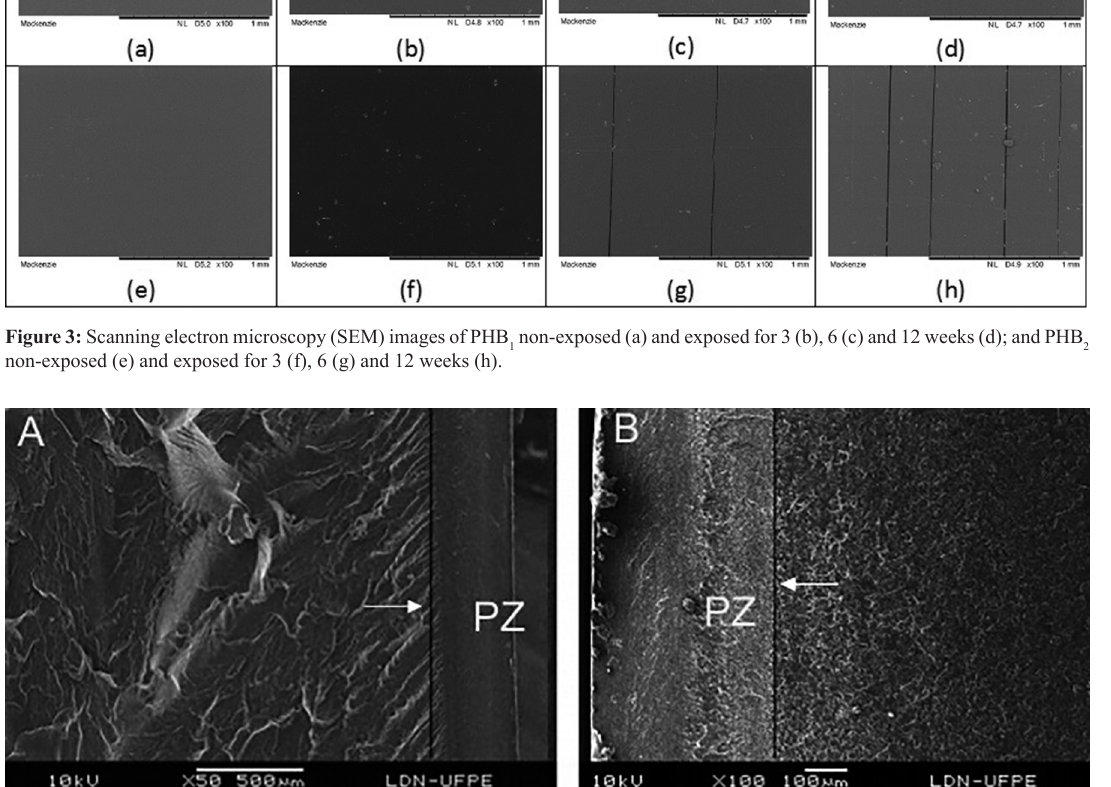
Figure 4: SEM images of fractured surface of PHB interface between the degraded and the not-degraded material. (PZ: Photodegradaded Zone)